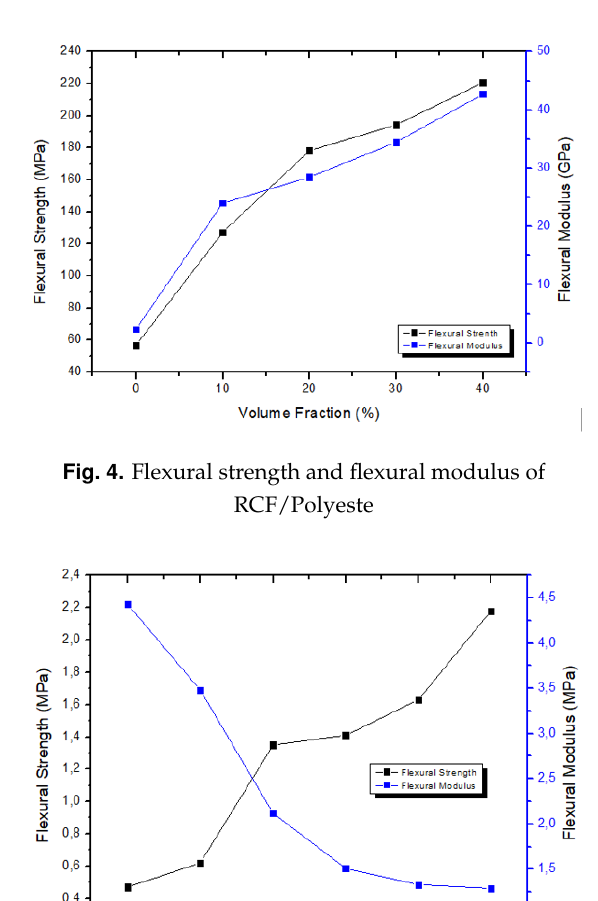
Fig. 7. Core Polyurethane Flexural